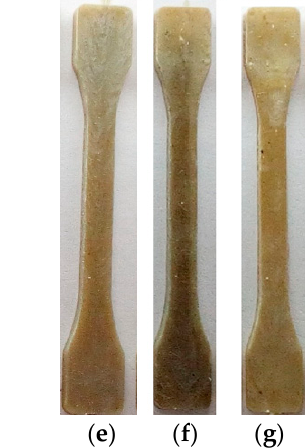
Table 3. Thermogravimetric analysis (TGA) data of PEI with the various content of OPSU and PC.